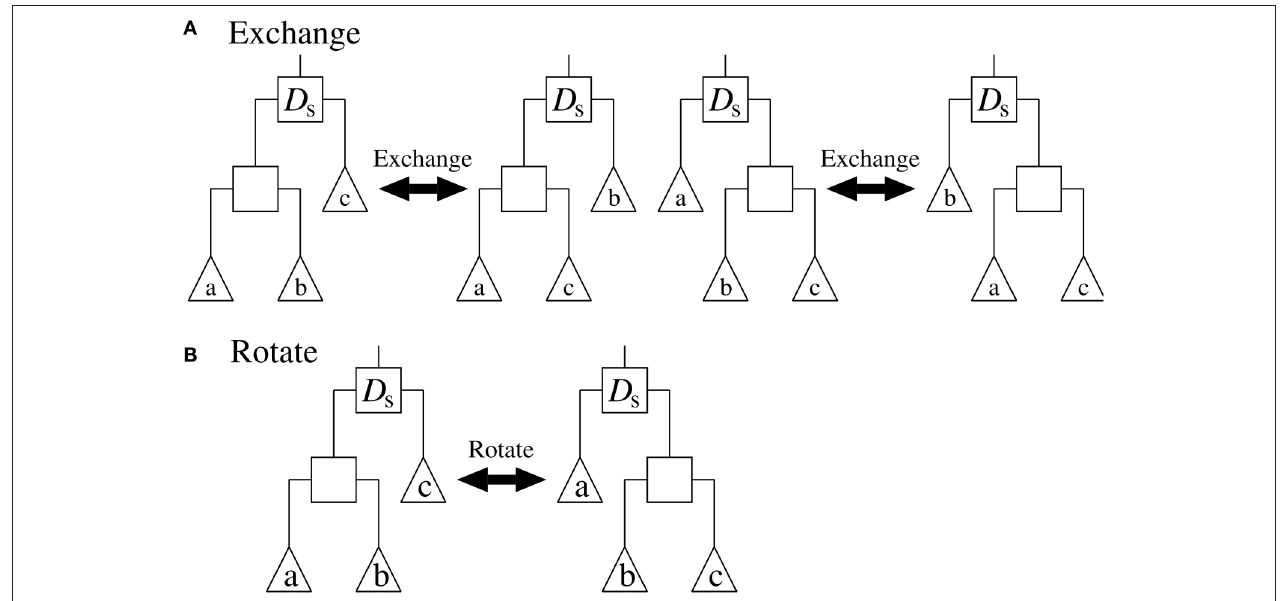
FIGURE 2 | The (A) “Exchange” and (B) “Rotate” operators applied to the internal node D s . Squares represent internal nodes, and triangles represent leaf nodes and/or